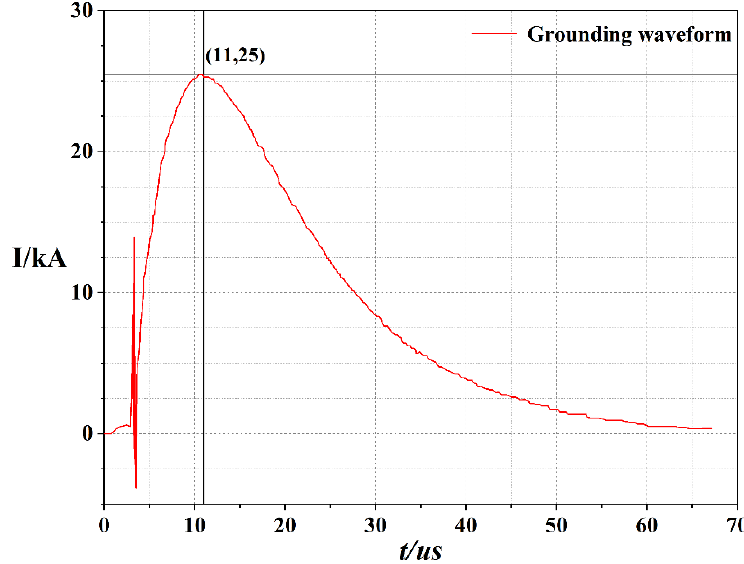
Figure 11. Experimental grounding waveform.